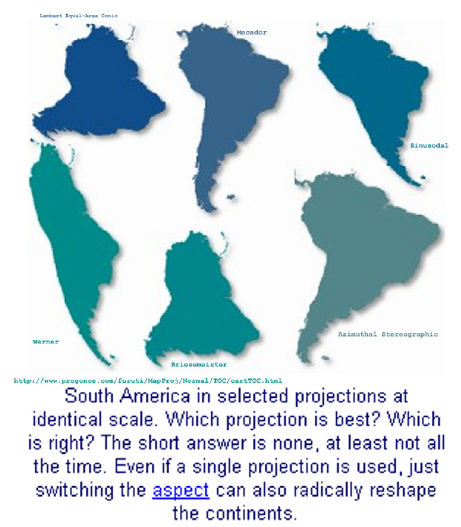
Fig. 3. An illustration of South America in a variety of cartographical projections (source: http://www.progonos.com/furuti/MapProj/